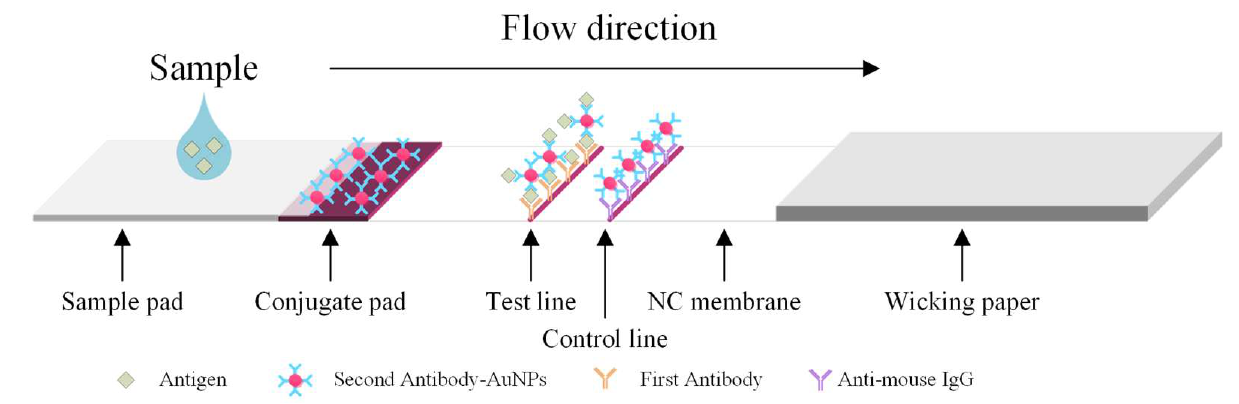
Figure 1. Principle of the lateral flow test.